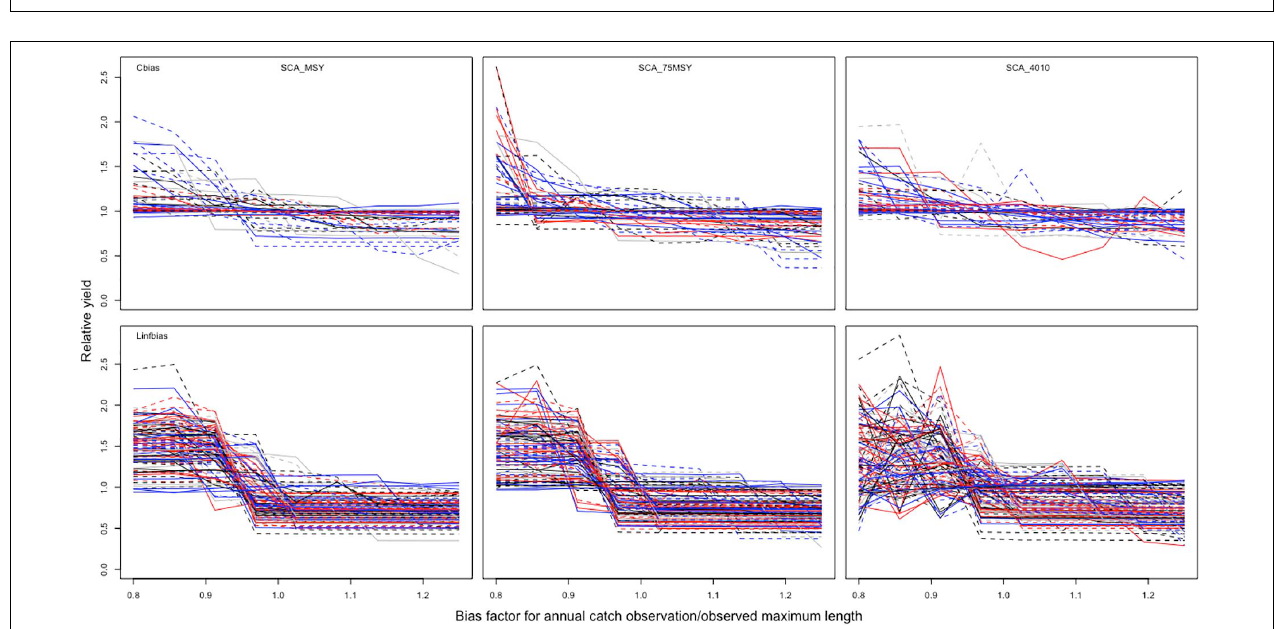
FIGURE 2 | Results of 128 simulations of the parameters Cobs and Iobs with three MPs.